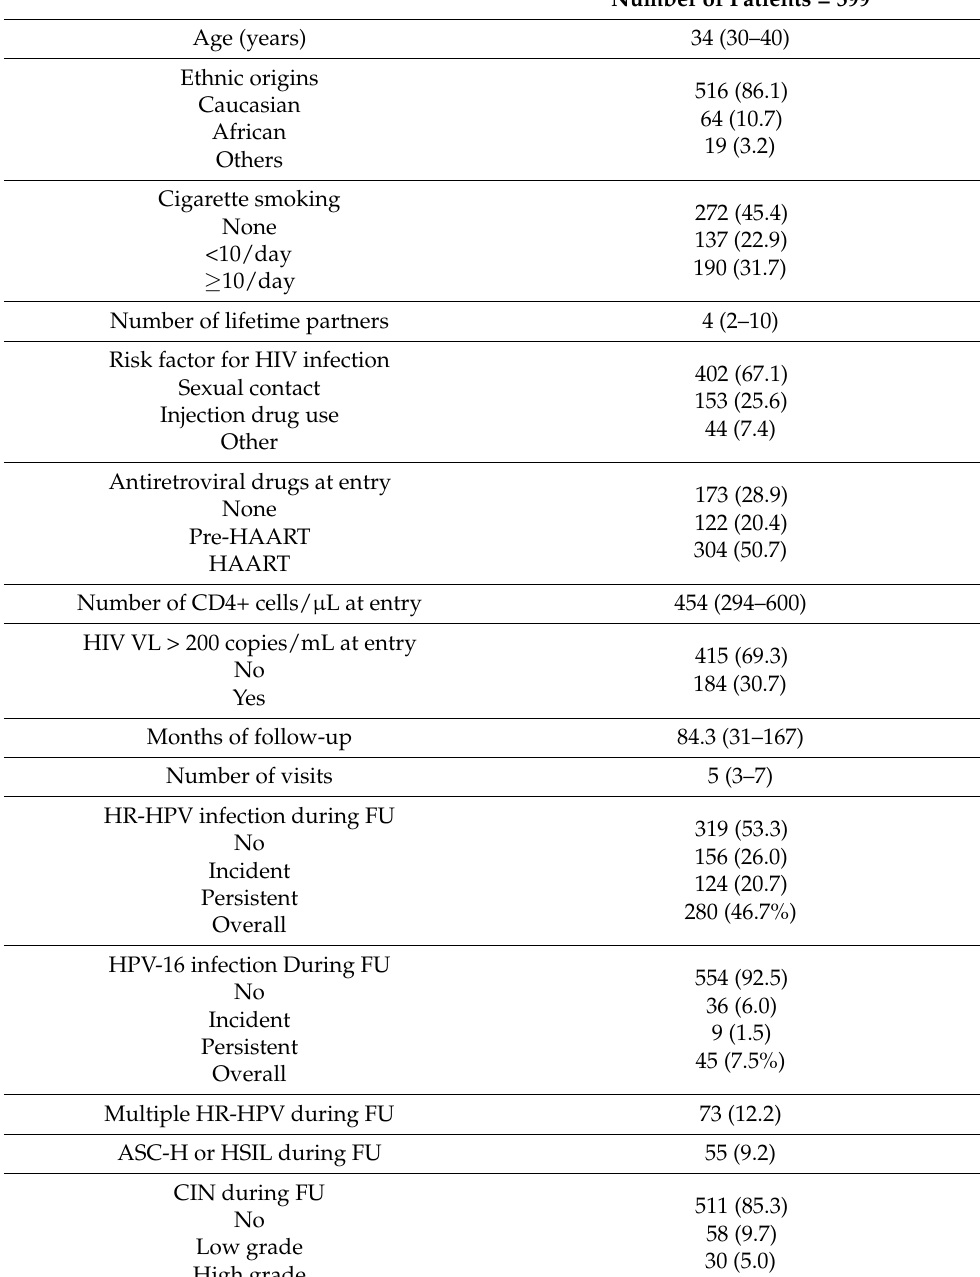
Table 1. The main characteristics of the population considered in the study at